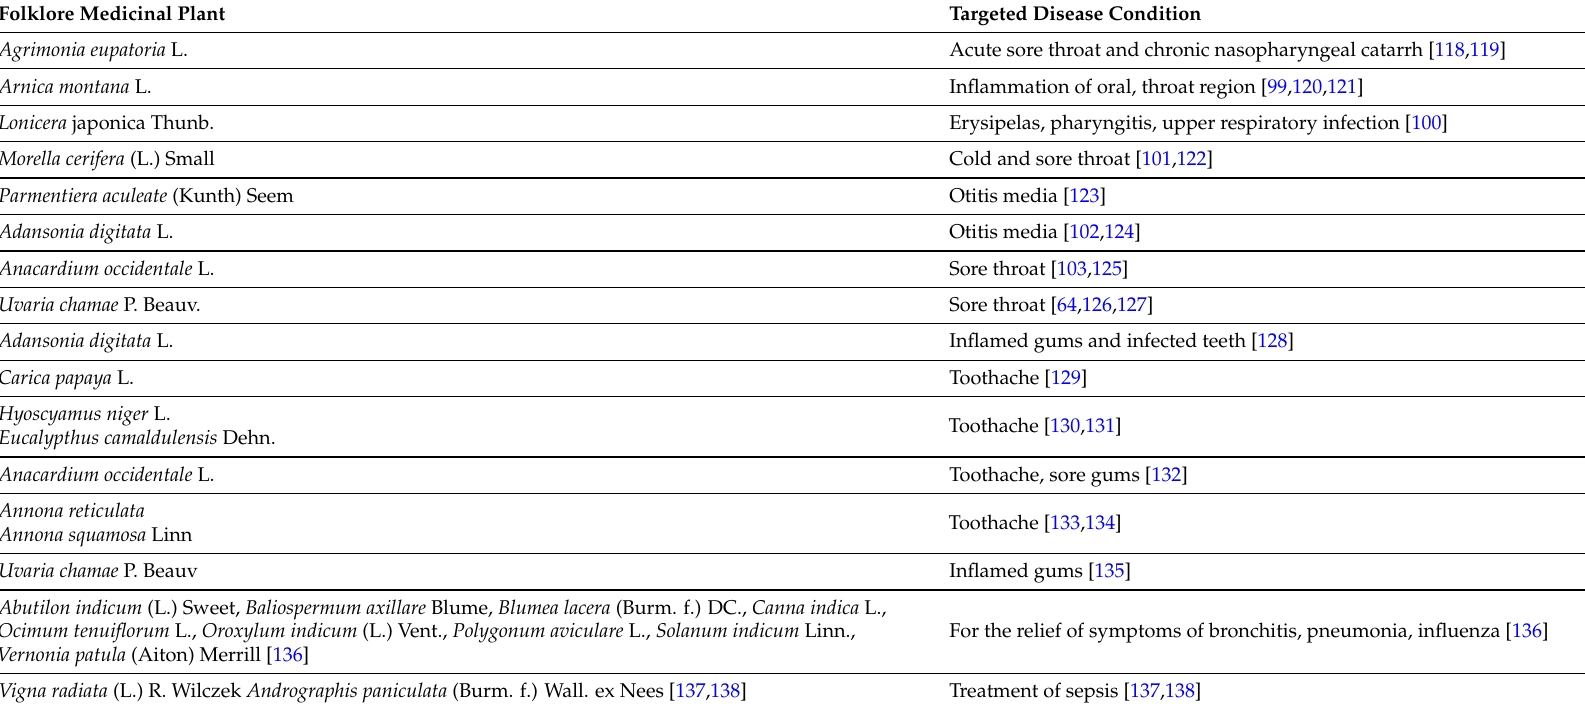
Table 2. Folklore medicine used for Streptococcal diseases or diseases with similar clinical